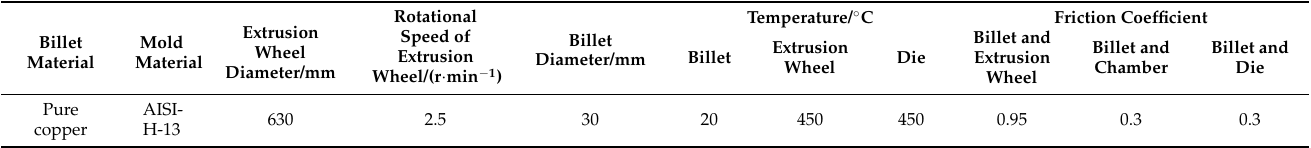
Table 1. Material properties and simulation